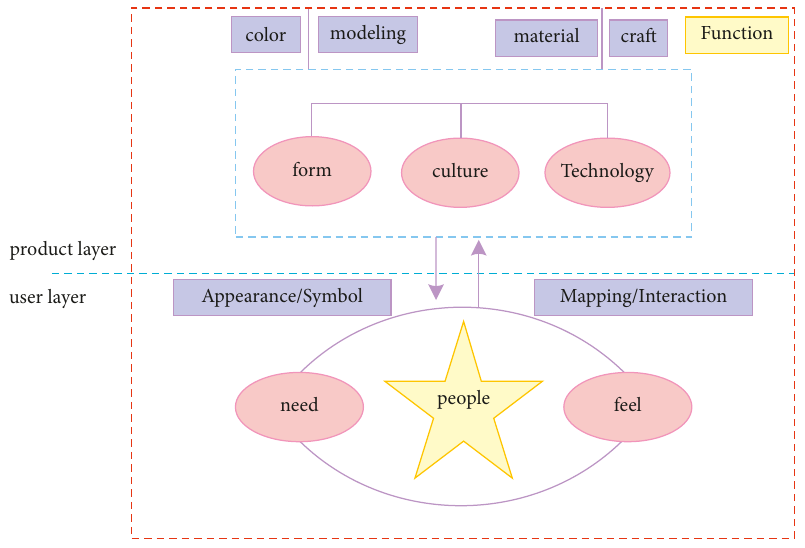
Figure 2: The category of industrial design product aesthetics.